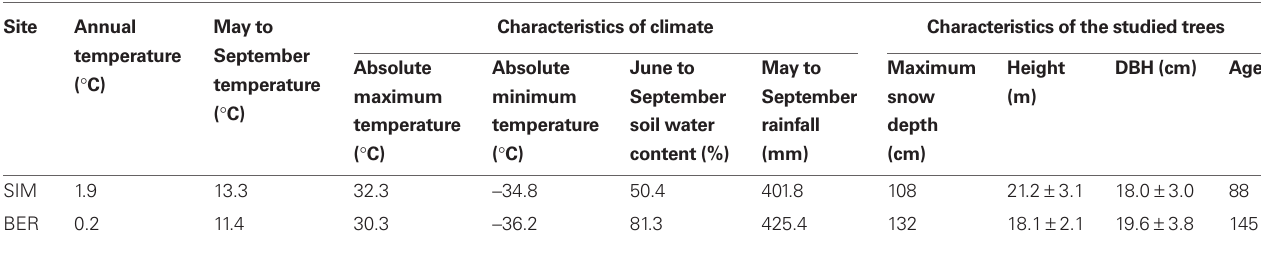
Table 1 | Characteristics of climate and studied trees [height, diameter at breast height (DBH), and age] of two black spruce stands in the boreal forest of Quebec,